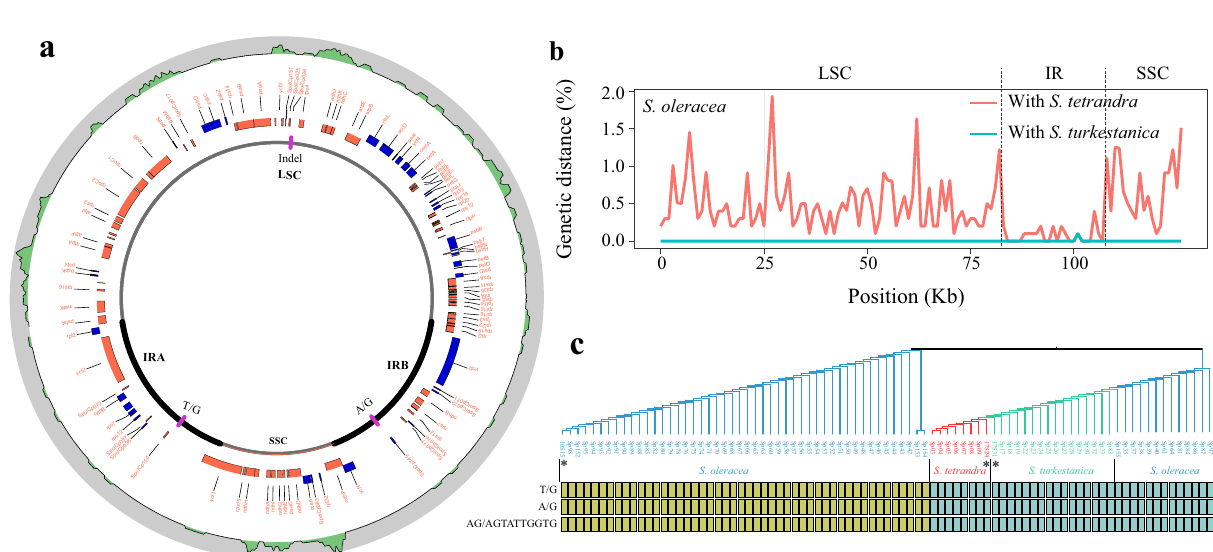
Figure 3. Variability of the three Spinacia species based on the chloroplast genome. ( a ) The purple lines in the innermost circle correspond to variants between S. turkestanica and S. oleracea . The green region in the outermost circle corresponds to variants between S. tetrandra and S. oleracea with a 1-Kb window and 100-bp steps. Genes represented by blue rectangles are on the positive strand while genes represented by red rectangles are on the negative strand. ( b ) Genetic distance between S. oleracea and the wild relative chloroplast assemblies of S. tetrandra (red) and S. turkestanica (blue). ( c ) The phylogenetic tree was constructed based on three variants between S. turkestanica and S. oleracea using 85 Spinacia accessions, including eight S. tetrandra , 16 S. turkestanica , and 61 S. oleracea individuals. Yellow rectangles indicate that the homozygous genotype in the accession was consistent with the reference chloroplast genome, whereas blue rectangles indicate that the homozygous genotype differed from the reference chloroplast